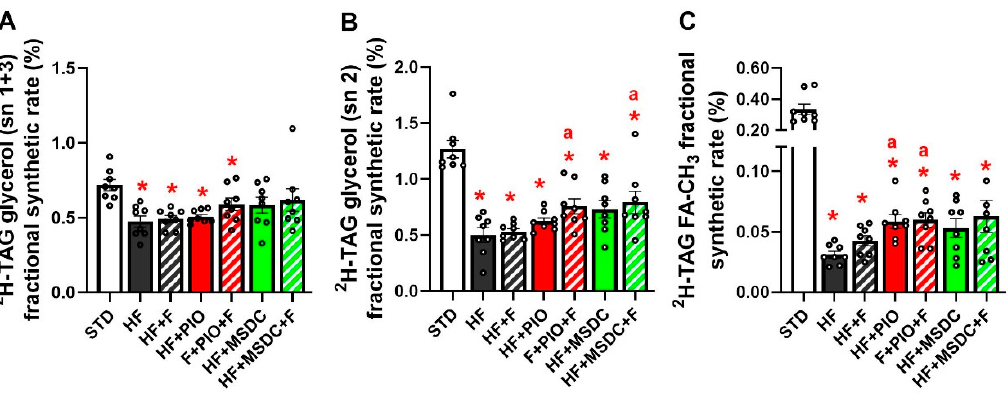
Figure 4. TAG synthesis and DNL in eWAT in vivo. Measurement of TAG synthesis ( A , B ) and DNL (FA de novo synthesis; ( C )) in eWAT was performed using in vivo 2 H 2 O incorporation in TAG in mice fed STD or various HF diets for 8 weeks. Analysis of total 2 H enrichment in sn 1 + 3 ( A ) and sn 2 ( B ) position of glycerol, and in FA methyl moieties of TAG ( C ), was performed using NMR spectroscopy. Data are means ± SEMs ( n = 8). * Significantly different from STD ( p ≤ 0.05, t -test). a—significantly different vs. HF ( p ≤ 0.05, one-way ANOVA). TAG: triacylglycerol; DNL: de novo lipogenesis; NMR: nuclear magnetic resonance. For designation of dietary groups, see Section 2.1.